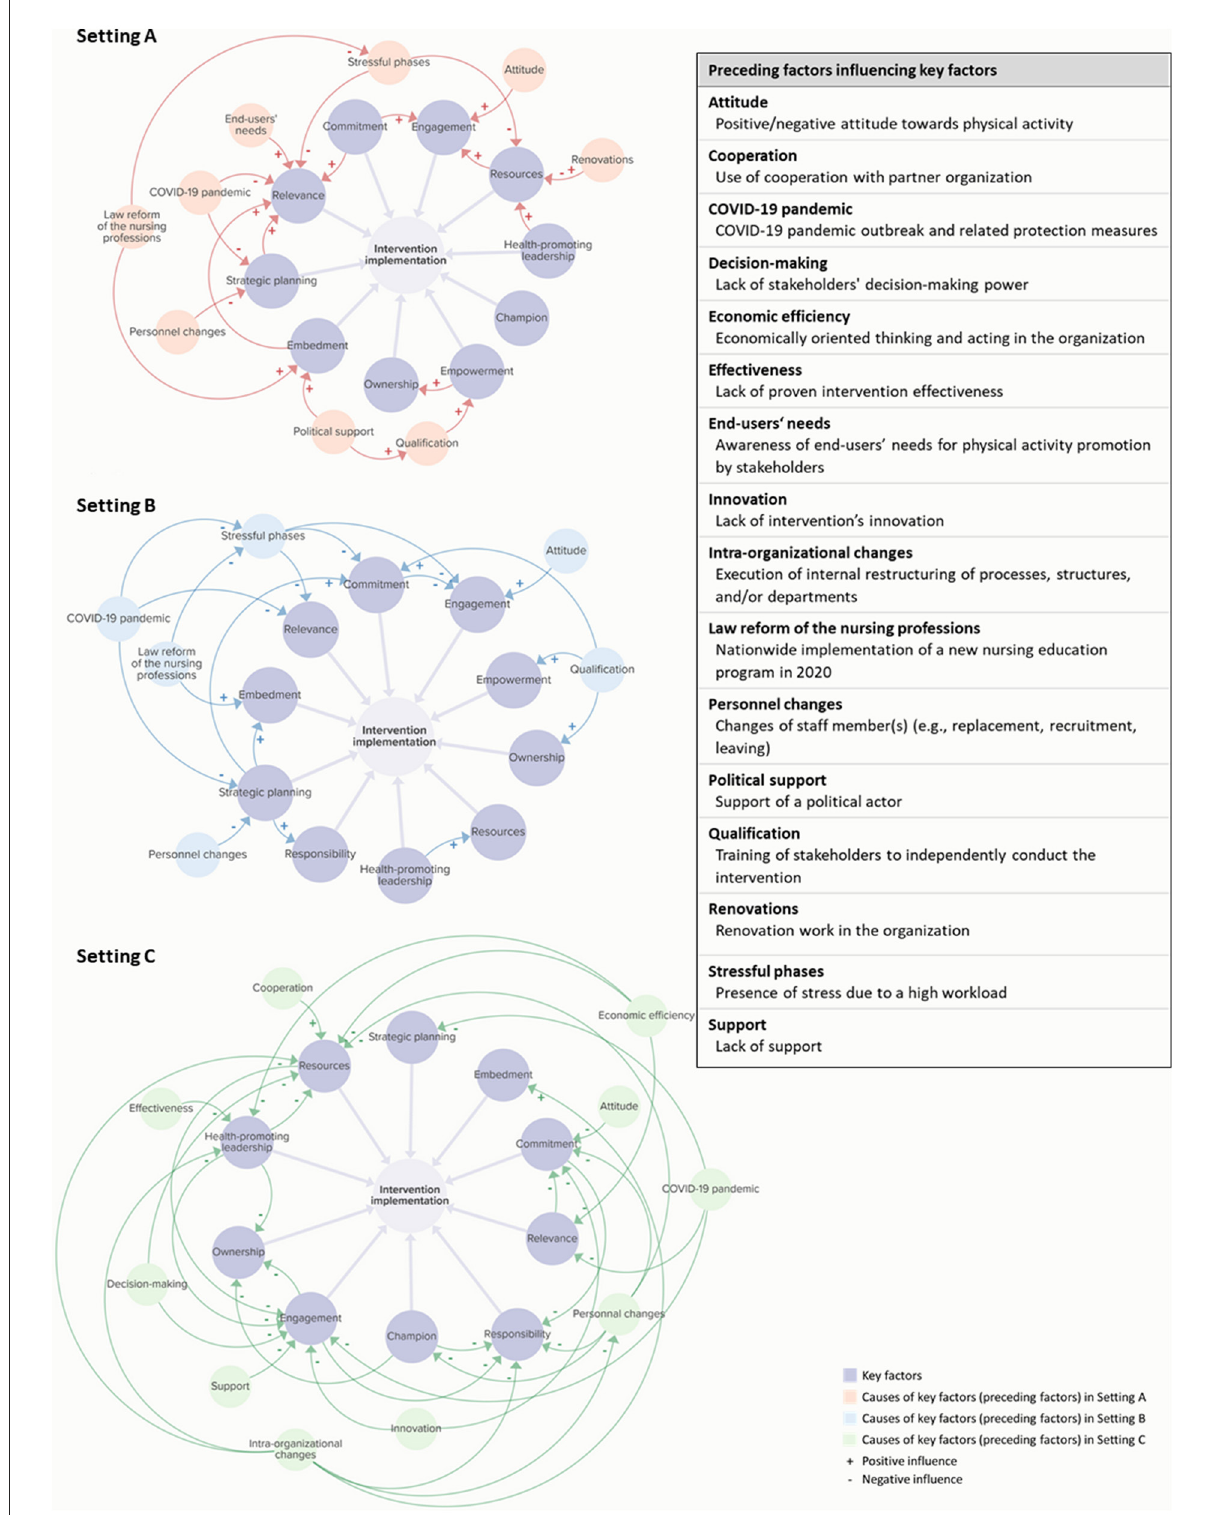
FIGURE4 Reported causal relationships of key factors and preceding factors influencing intervention implementation identified through qualitative content analysis. The causal loop diagrams were produced using Kumu Inc (retrieved from